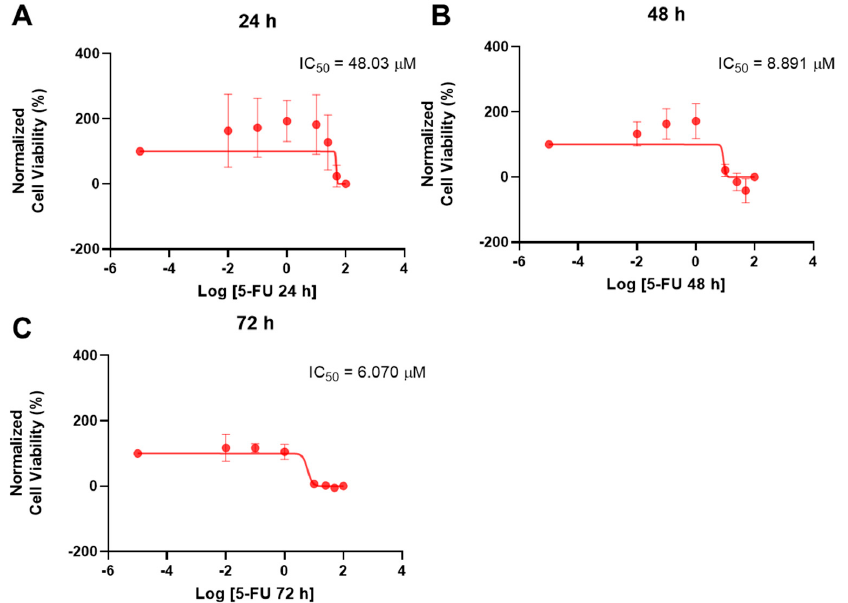
Figure 13. Dose-response curve and IC 50 of A549 after exposure to increasing concentrations of 5-FU (0.01–100 µ M) for 24 h ( A ), 48 h ( B ), and 72 h ( C ). Control cells were treated with 0.01% DMSO (vehicle). Cell viability was obtained using the MTT assay and the results were normalized and are given as the mean ± SEM ( n = 3).